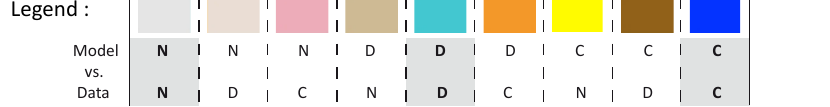
Fig. 8. LGM permafrost comparison between IPSL-CM4 and the Vandenberghe et al. (2011) permafrost index. (a) Is obtained with a bilinear interpolation of temperatures and the RV conditions to derive permafrost. (b) Is the same from the downscaled temperatures by GAM. (c) Is the downscaled permafrost index by ML-GAM. In the legend panel,“N” corresponds to “No permafrost”, “D” to “Discontinuous permafrost” and “C” to “Continuous permafrost”. The highlighted categories with bold letters show the agreement between model and data.